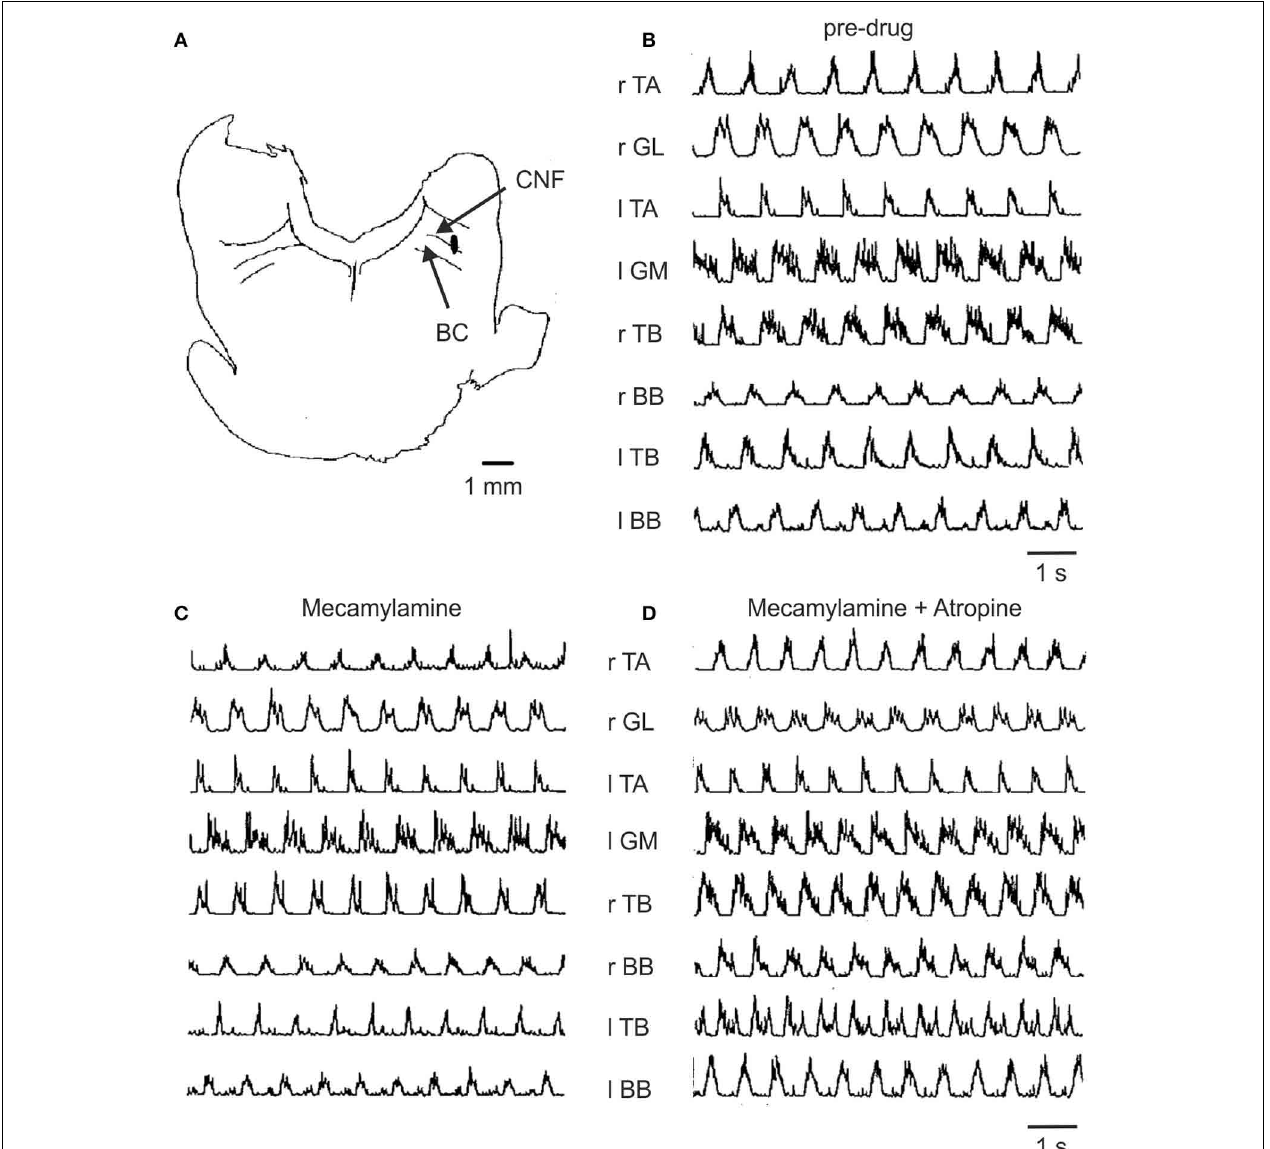
FIGURE 5 | Effect of mecamylamine and atropine on locomotion induced by electrical stimulation of the MLR. (A) Site of stimulation was localized to the ventrolateral border of the cuneiform nucleus (CNF) near the brachium conjunctivum (BC) at P2, L4, H-1.5 (coordinates according to Berman, 1968). (B) Treadmill locomotion evoked from this brainstem site prior to any drugs